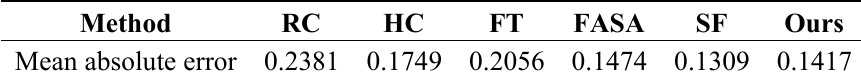
Table 2. The Mean absolute error to ground